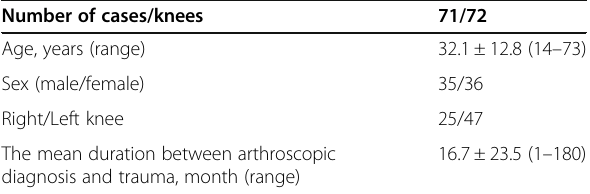
Table 3 Demographic characteristics of the study cohort Number of cases/knees